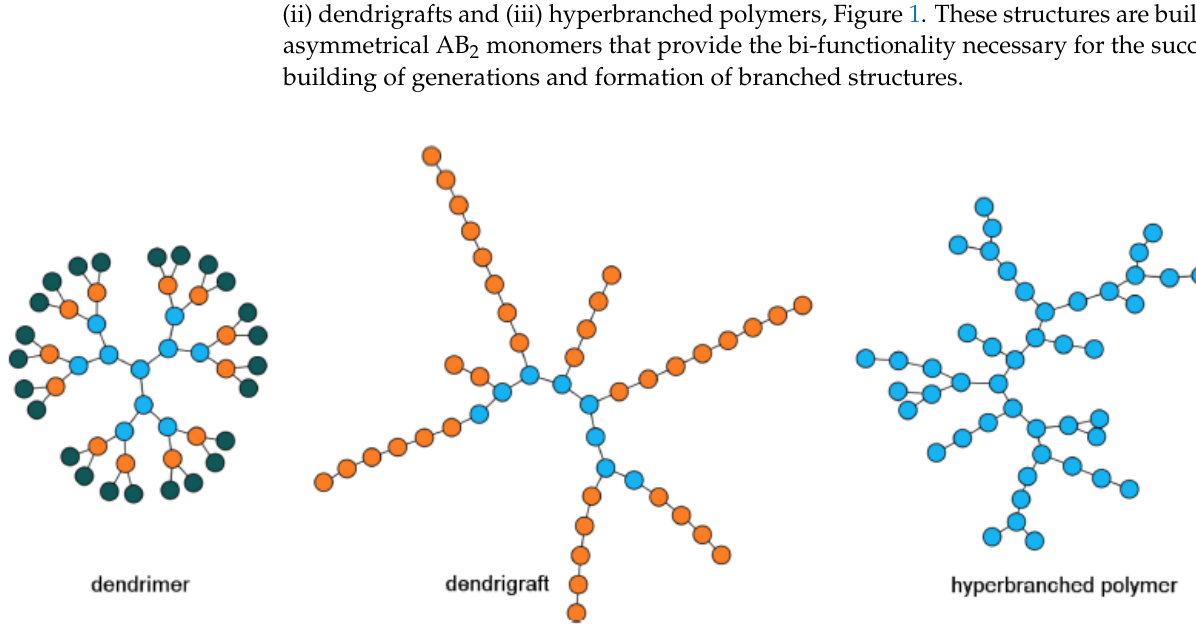
Figure 1. Highly branched polymers: ( left ): 3rd generation dendrimer, ( middle ): 2nd generation dendrigraft, ( right ): hyperbranched polymer; reproduced with permission from Francoia and Vial [21]